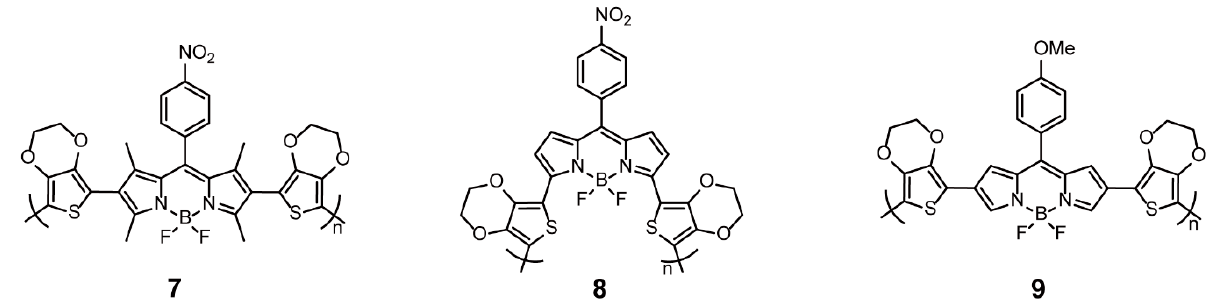
Figure 3. Chemical structures of polymers 7–9 ( Reproduced with permission from Reference [23]. Copyright @ 2009, Elsevier. Reproduced with permission from Reference [25]. Copyright @ 2009, American Chemical Society. Reproduced with permission from Reference [33]. Copyright @ 2014, Elsevier).